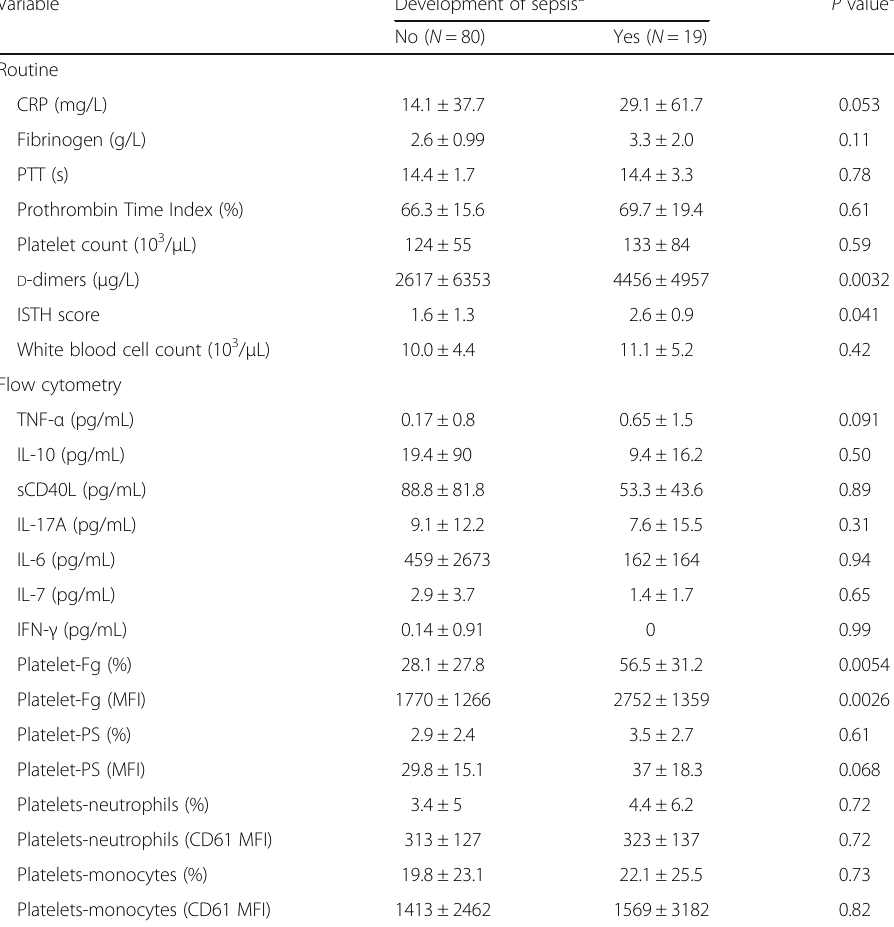
Null values for TNF- α and IFN- γ correspond to values under the level of detection (3.8 pg/ml) Platelet-Fg platelet-bound fibrinogen, platelet-PS , platelets expressing P-selectin on their surface, MFI median fluorescence intensity, % percentage of positive cells for the indicated marker a Results are expressed as